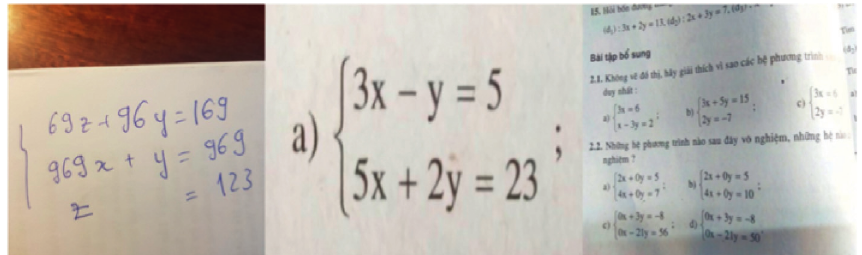
Figure 2: Preparing your data.